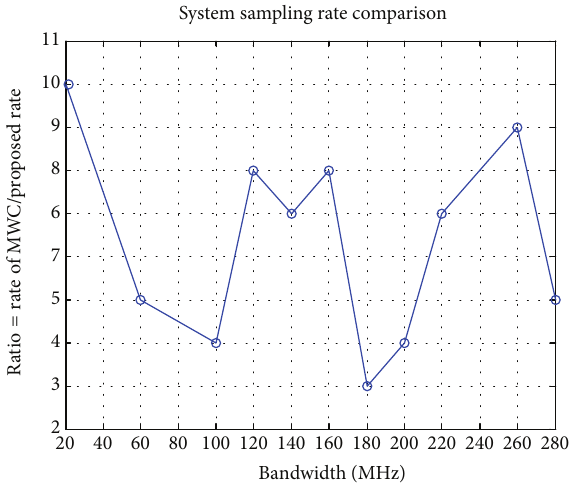
Figure 9: System sampling rate